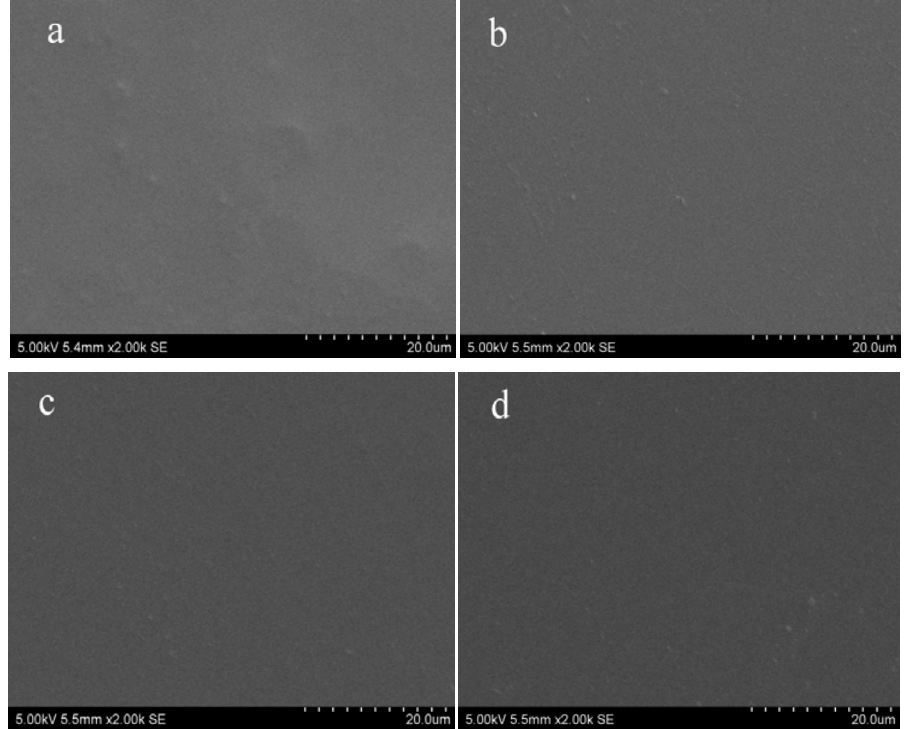
Figure 1. Scanning electron microscope (SEM) images of films: ( a ) control sample; ( b ) cellulose film plasticized with sorbitol; ( c ) cellulose film plasticized with glycerol; ( d ) cellulose film plasticized with carboxymethyl cellulose (CMC).